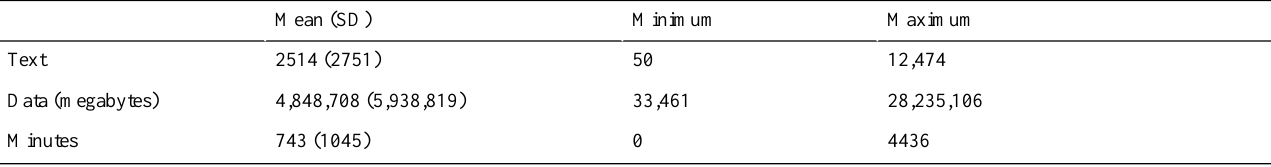
Table 1. Mobile phone service usage over 30